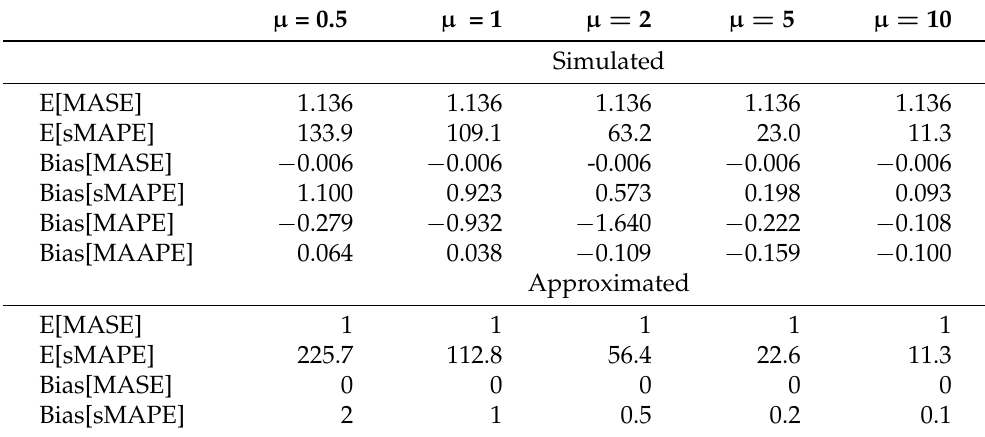
Table A1. Simulated and approximated mean and bias of MASE and sMAPE for one-step